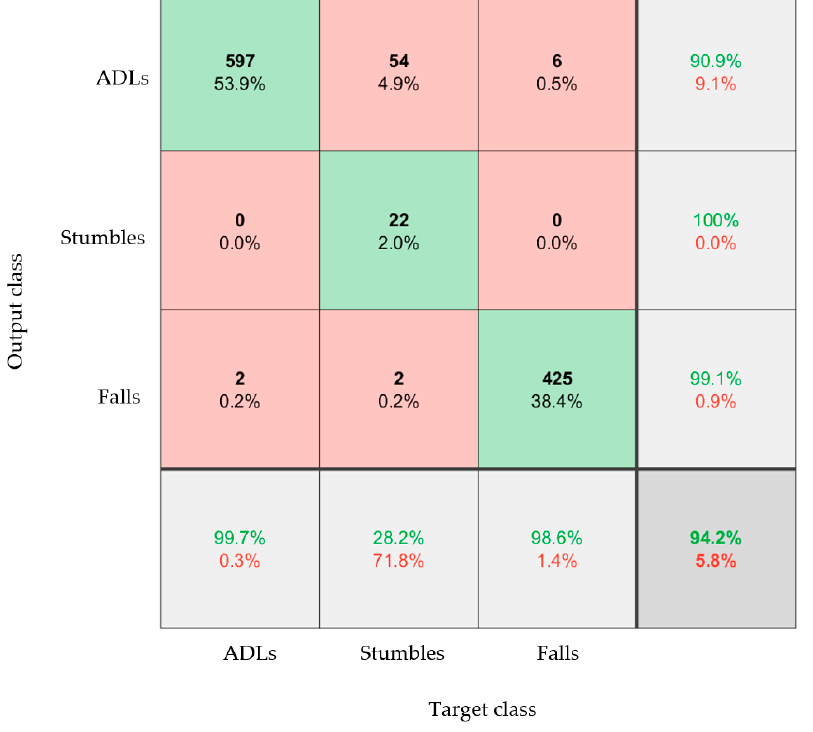
Figure 12. Confusion matrix that classifies between the three types of ADL (walking, sit to stand, timed up and go), the three types of fall, and a near ‐ fall event (stumble). The model was trained and tested using datasets from only the right foot and both acceleration and angular velocity data.